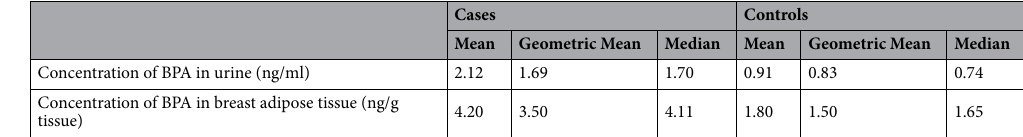
Table 3. BPA concentrations in cases and controls.